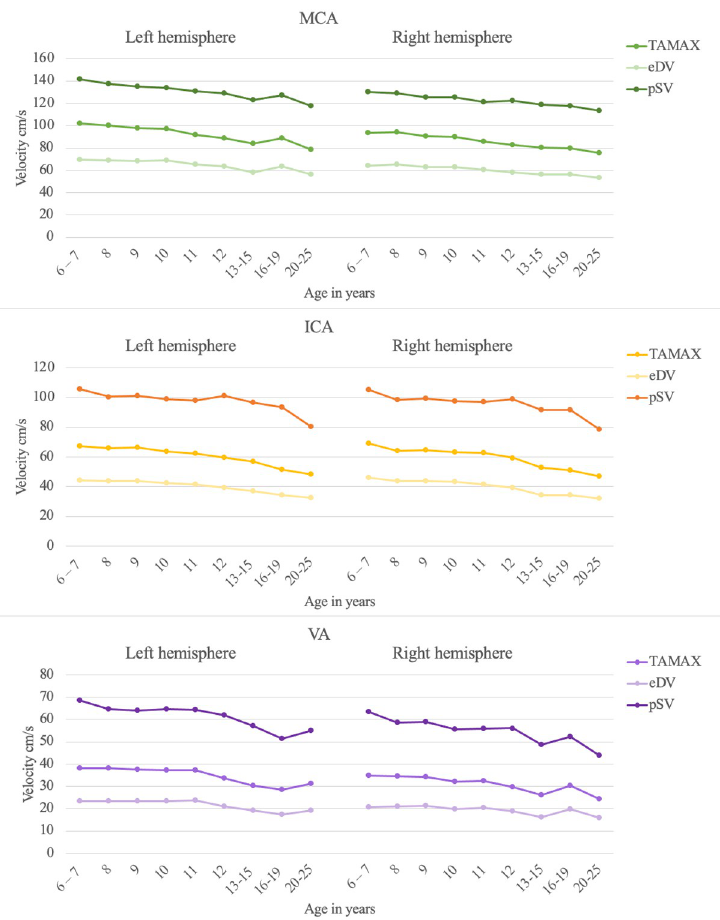
Fig 2. Velocities as a function of age, gender, blood vessel and hemisphere for the total sample. MCA = middle cerebral artery; ICA = internal carotid artery; VA = vertebral artery; TAMAX = time-averaged maximum flow velocity; eDV = end-diastolic velocity; pSV = peak systolic